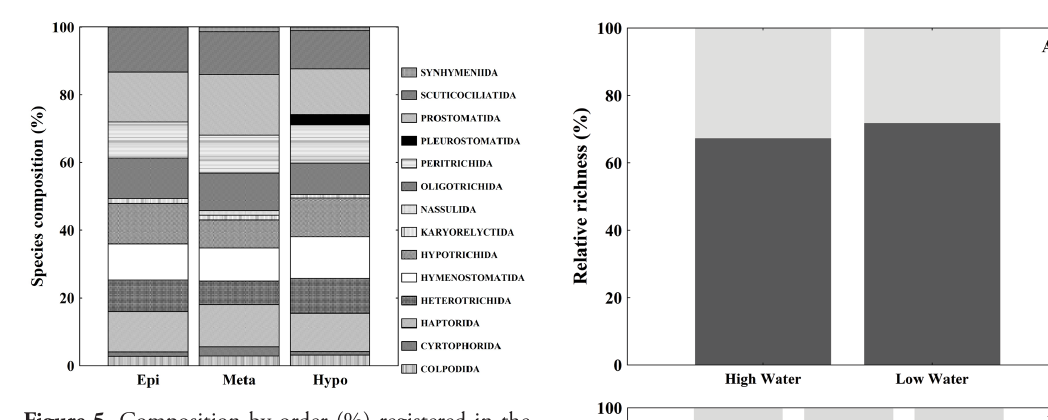
Figure 5. Composition by order (%) registered in the distinct strata in the Guaraná Lake. Epi=Epilimnion, Meta=Metalimnion, Hypo=Hypolimnion.